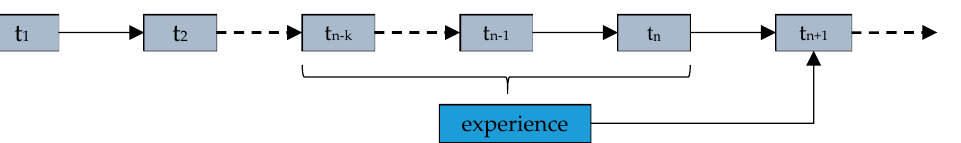
Figure 4. Markov property of individuals’ decision-making in the rainstorm.